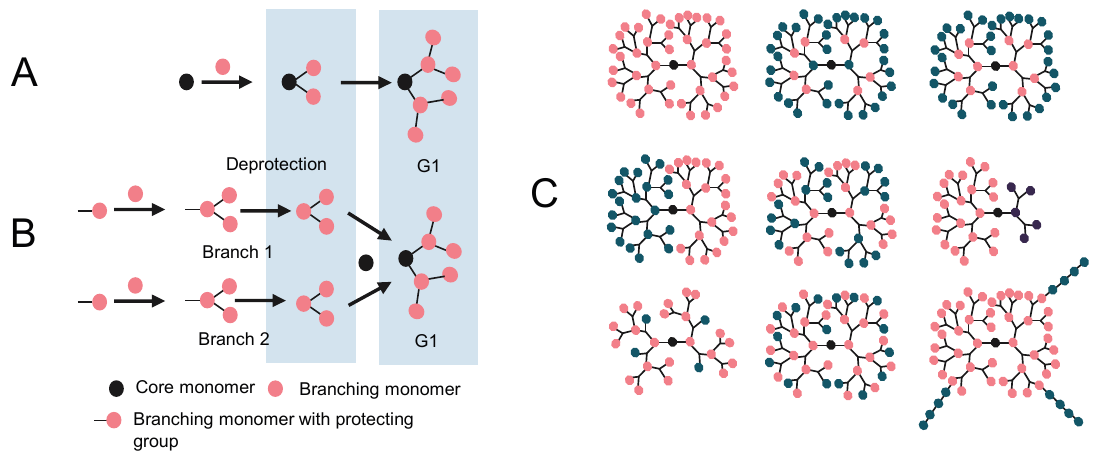
Figure 1. Structural properties of dendrimers; ( A ) Divergent synthesis; ( B ) Convergent synthesis; ( C ) Different topological structures that can be obtained from